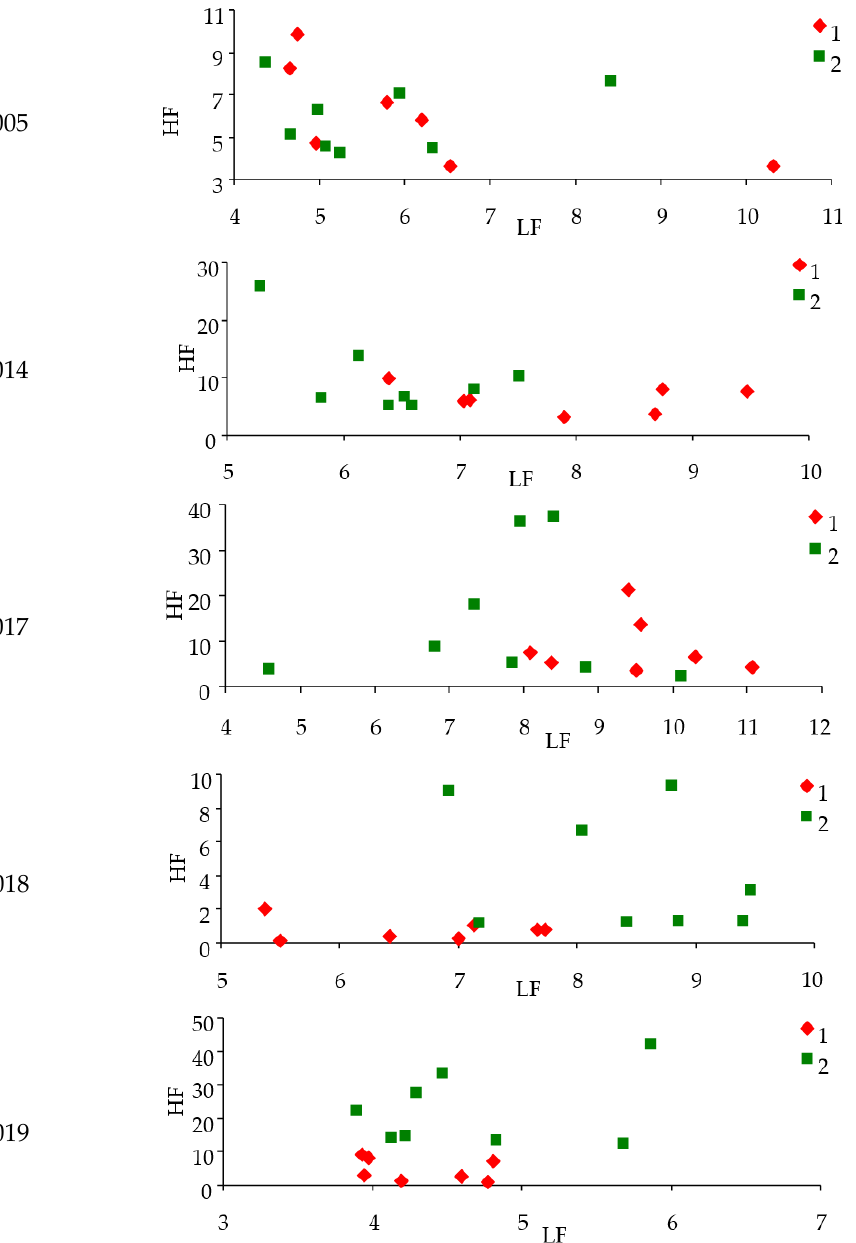
Figure 6. LF and HF parameters for Siberian silk moth outbreak (2015) in different years before and after outbreak. 1—damaged areas; 2—control stands.